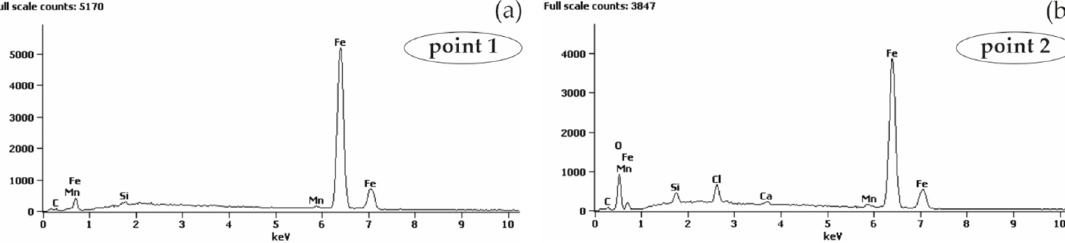
Figure 14. Spectra obtained from energy-dispersive X-ray spectroscopy (EDS) method for areas marked in Figure 13b: ( a ) from point 1 ( b ) from point 2